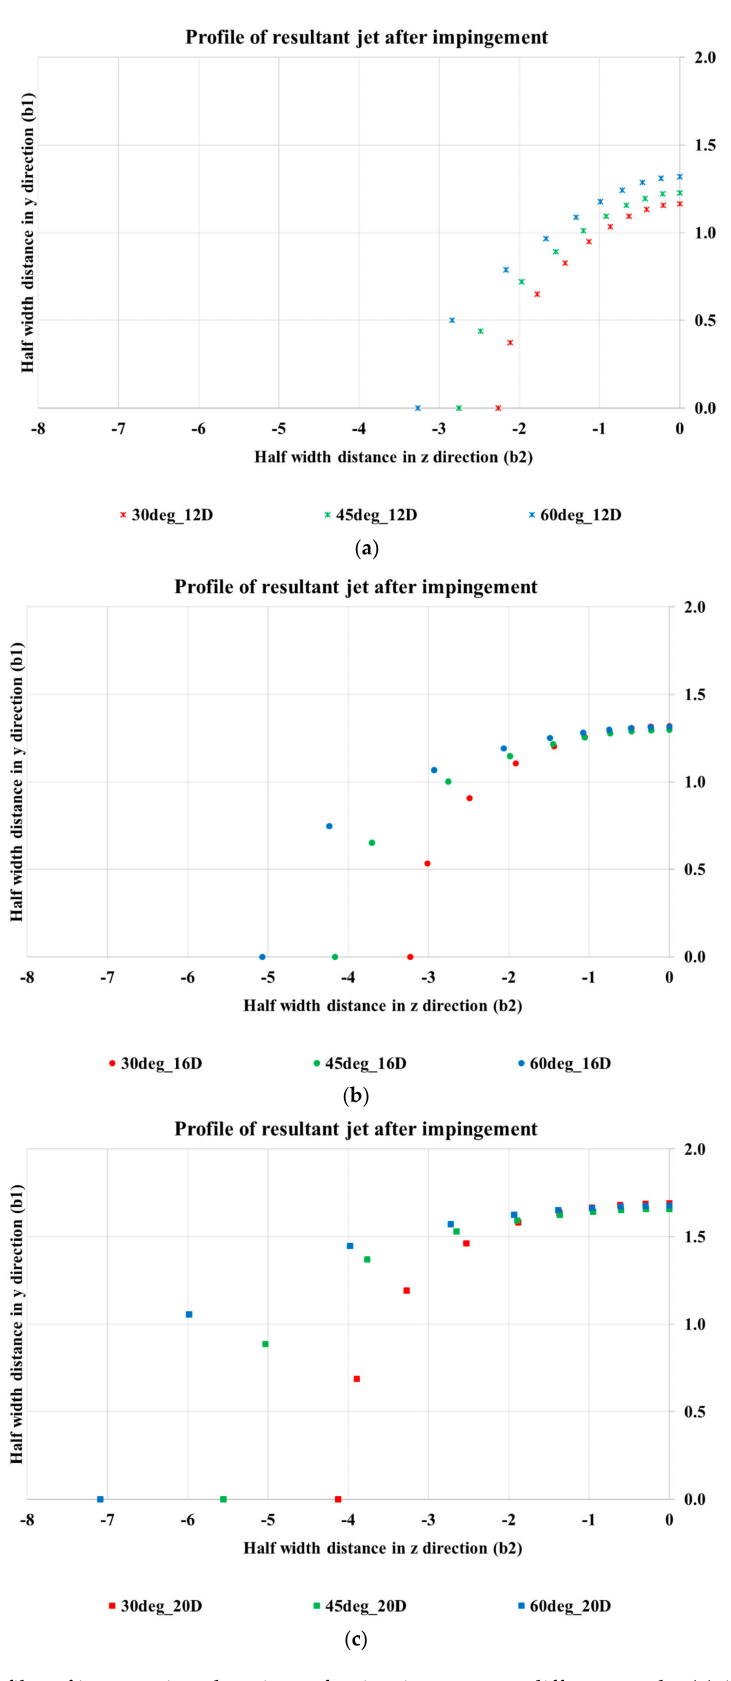
Figure 13. Profiles of jet at various locations after impingement at different angle: ( a ) 12 D; ( b ) 16 D; and ( c ) 20